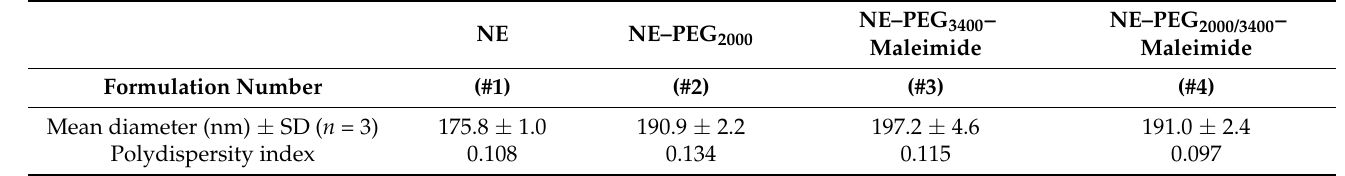
Table 1. NEs’ physicochemical